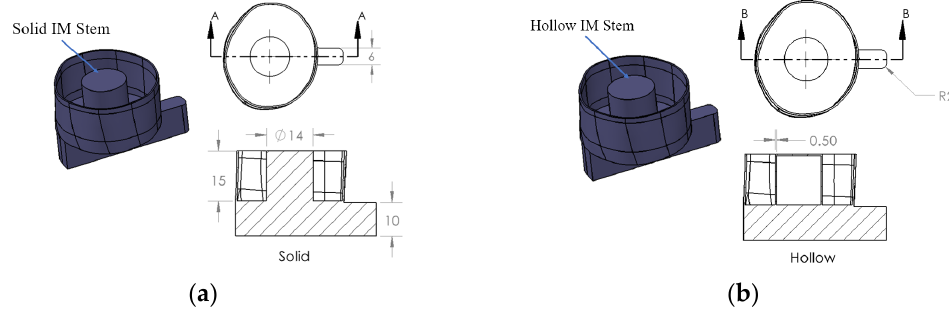
Figure 3. Oval–shaped implant model and dimension developed based on Patent US20200188140: ( a ) implant with solid IM stem and ( b ) implant with hollow IM stem.